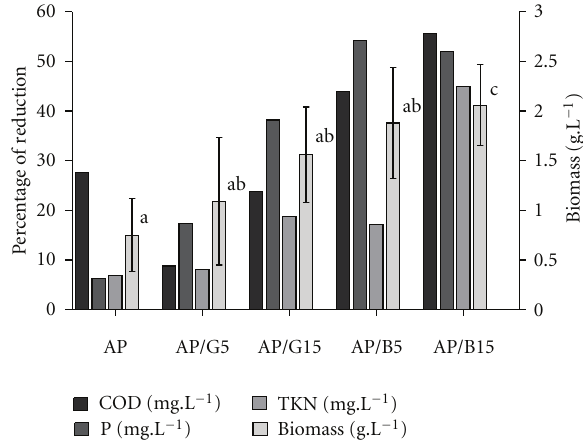
Figure 1: Chemical oxygen demand (COD), phosphorous (P- PO 43 − ), nitrogen (TKN), and biomass after 70 h of culture in e ffl uent from parboiled rice industry, with or without p.a. or biodiesel glycerol. AP: plain e ffl uent from rice parboiled maceration tanks; AP/G5 supplemented with 5 g · L − 1 of p.a. glycerol.; AP/G15 with 15 g · L − 1 p.a. glycerol; AP/B5 with 5 g · L − 1 of biodiesel glycerol; letters: significant di ff erences ( α = 0 .